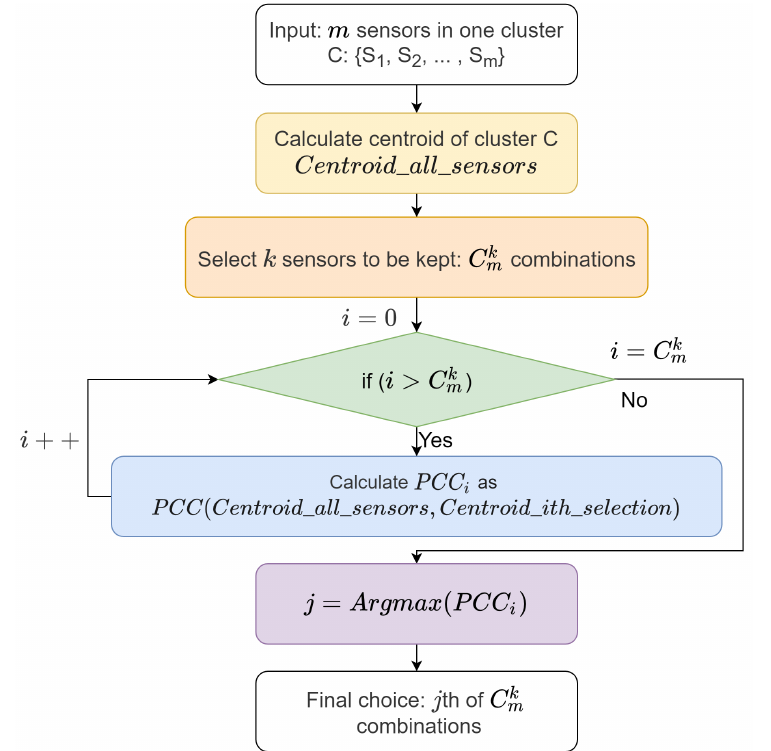
Figure 5. PCC-based sensor removal